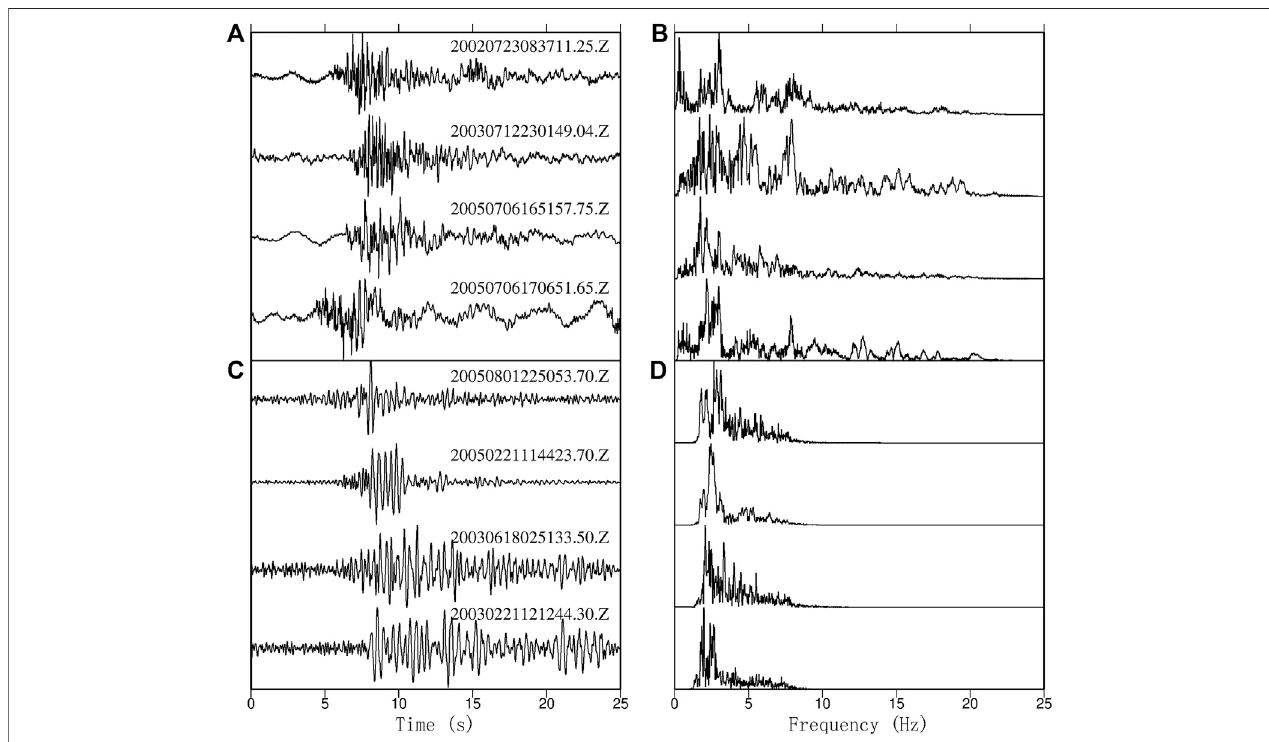
FIGURE 9 | Some representative HS and LP events recorded by station CBS. All of these waveforms have been normalized before plotting. (A,B) Original waveforms and normalized spectral functions of vertical components, respectively, of HS events. (C,D) Original waveforms and normalized spectral functions of vertical components, respectively, of LP events. The numbers above the waveforms indicate the time of origin of the